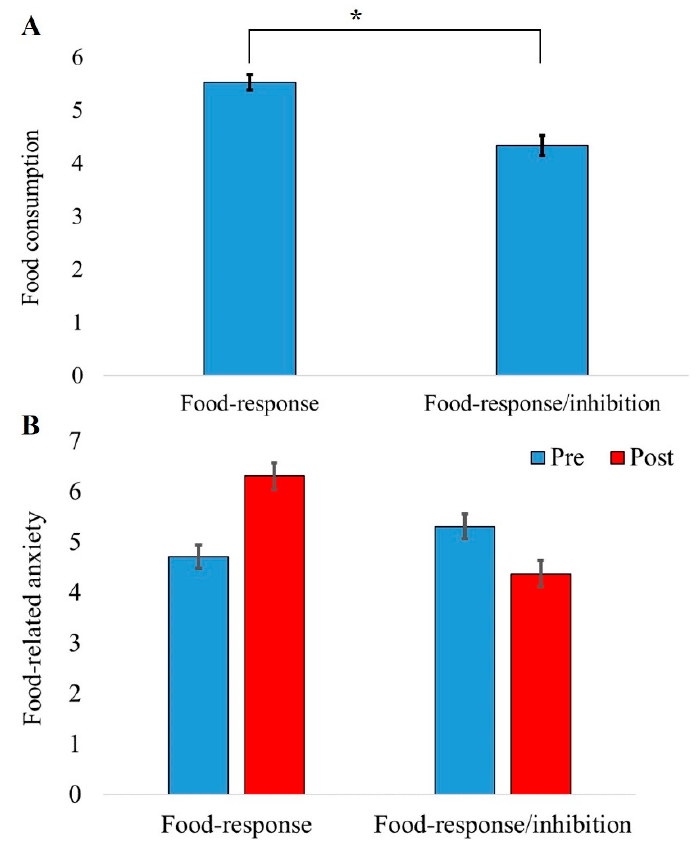
Figure 2. ( A ) Differences in snack consumption between the food-response and the food-response/inhibition training groups. The y- axis represents the total number of snacks eaten from the three bowls. ( B ) Changes in food-related anxiety as a function of training group and time. The y -axis shows the food-related anxiety score on the visual analog scale (VAS). The x -axis represents group. Error bars represent 1 standard error from the mean. * indicates p < 0.05.